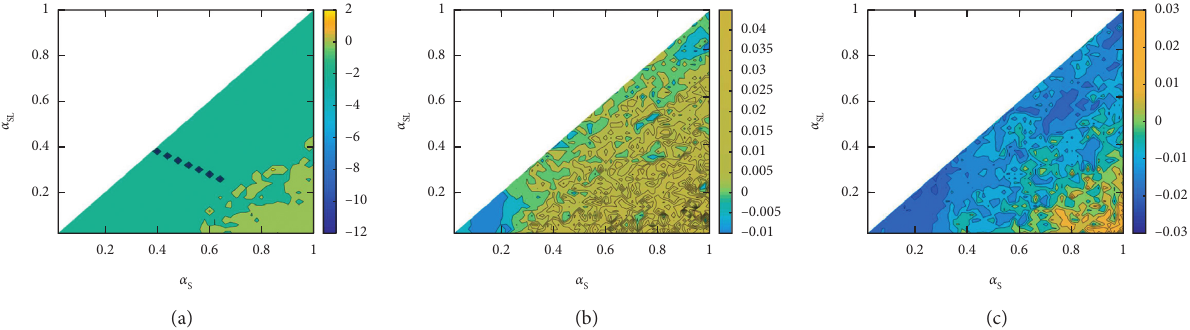
Figure 17: LLE diagram of supply chain nodes under the scenario of random demand obeying uniform distribution from local perspective � 4. (a) The retailer’s LLE chart. (b) The LLE chart of the distribution center. (c) The LLE chart of the combined system when G d � 1 and G 1 from the decision perspective.